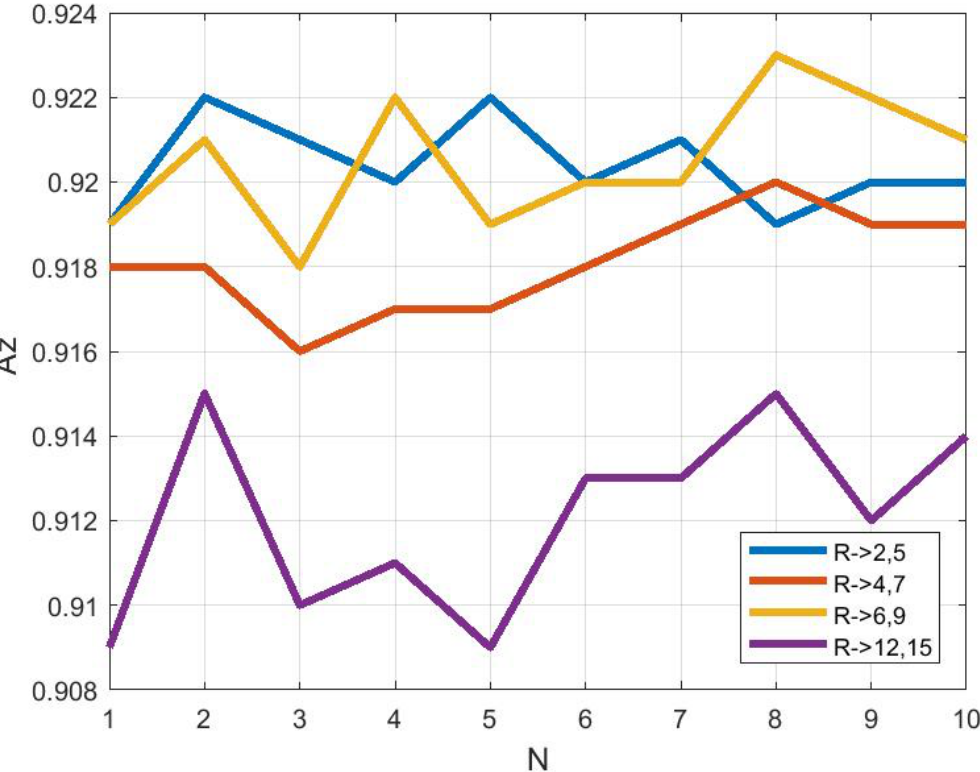
Figure 8. Area under ROC curve A z as a function of descriptor size (N indicates a distinct